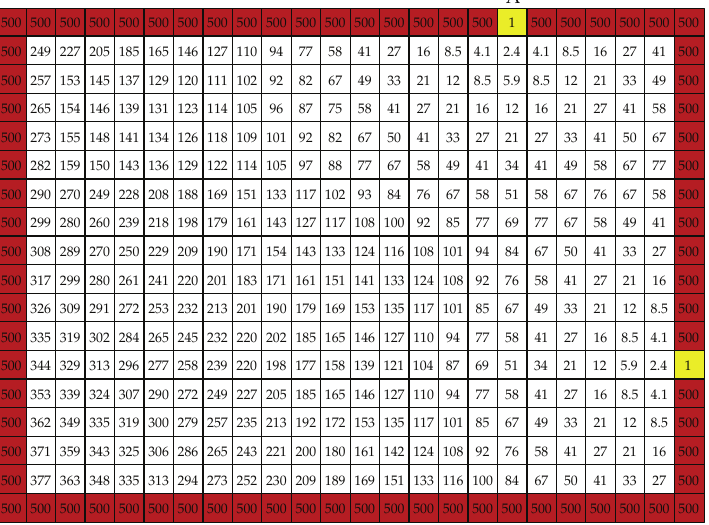
Figure 3: Values of the floor field in Figure 2 for the proposed dynamic model at the first time step.